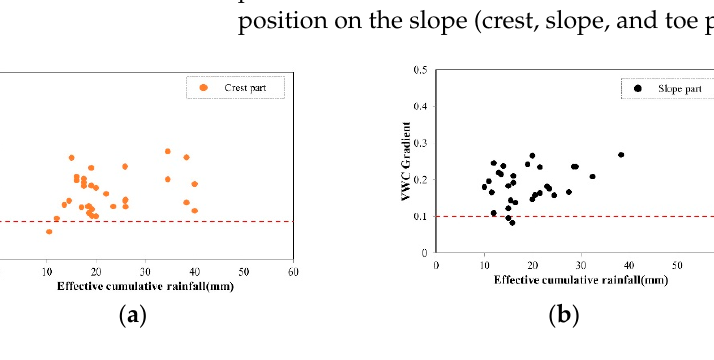
Figure 5. VWC gradient at different measurement locations (depths): ( a ) crest; ( b ) slope part; ( c ) toe part.